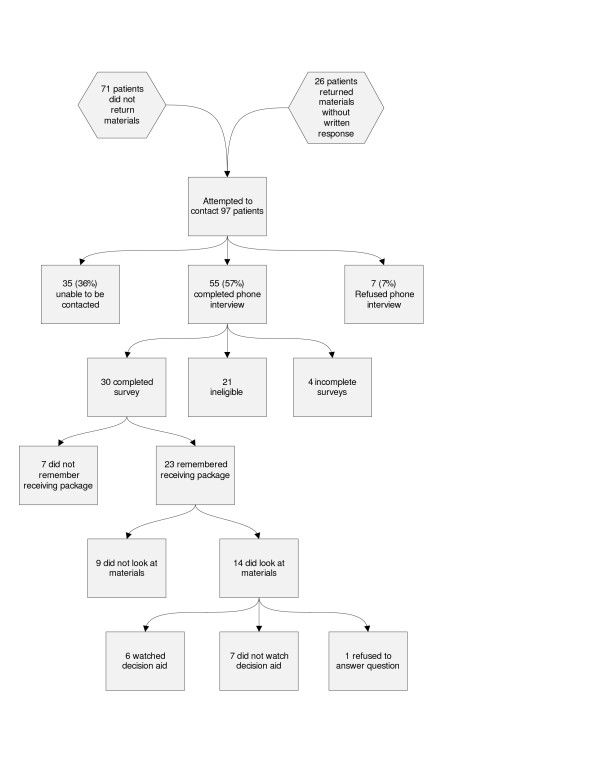
Phone call response.